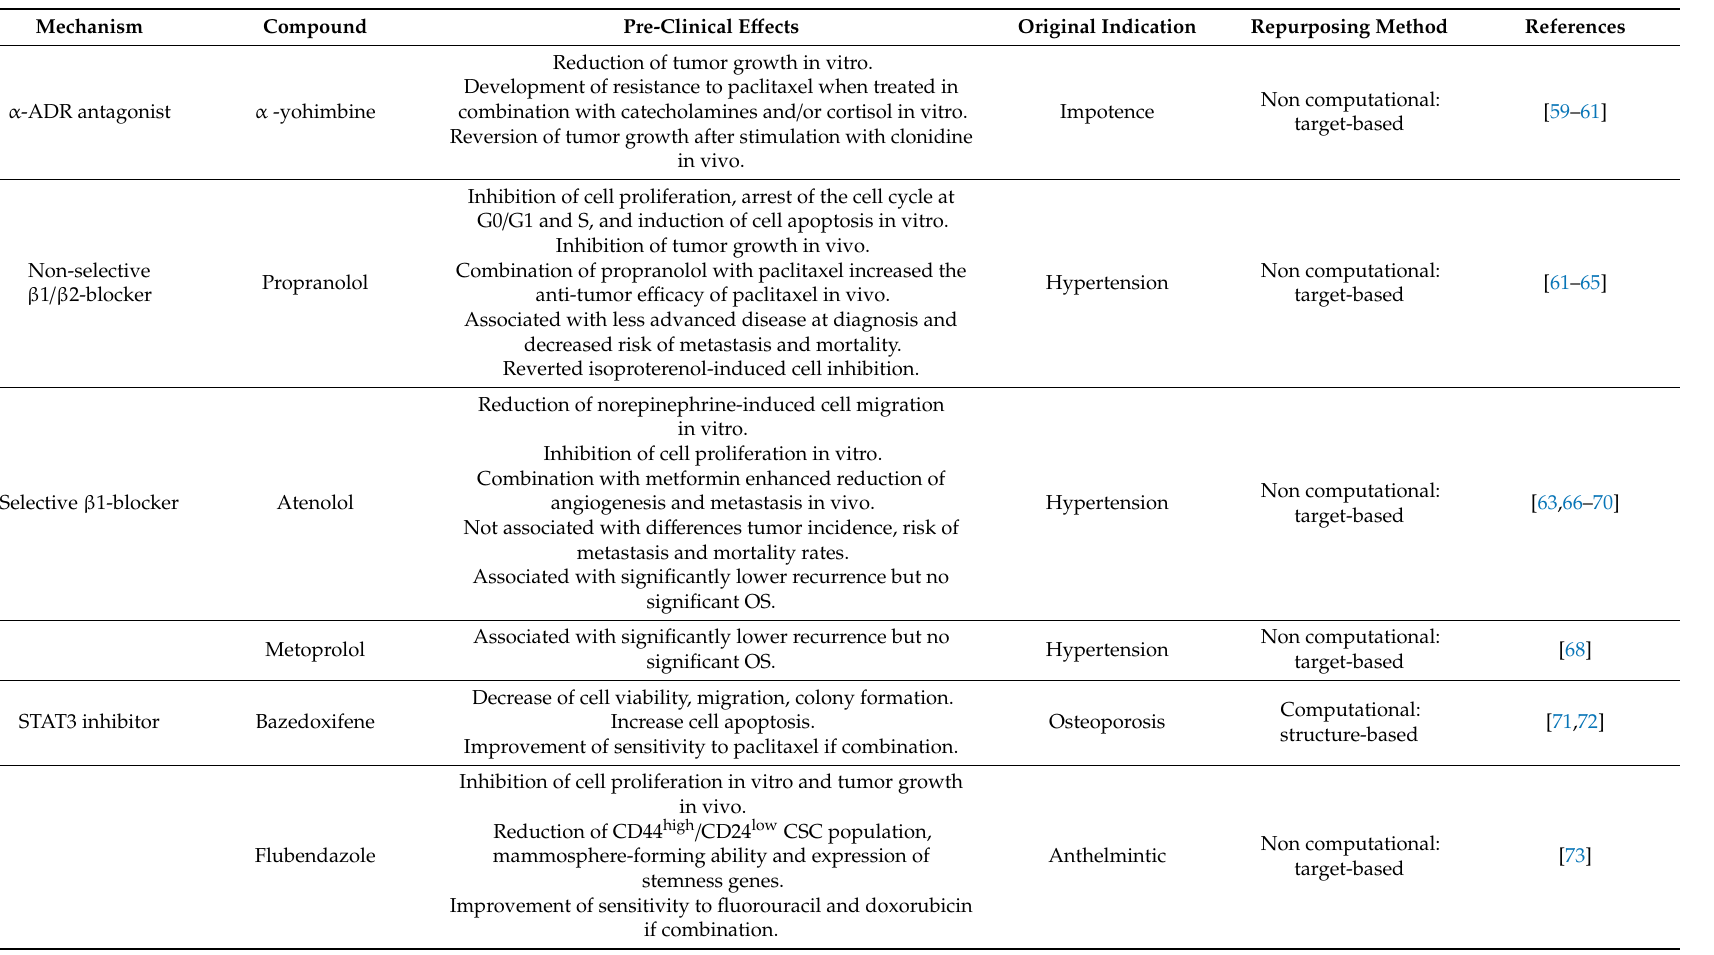
Table 3. Summarized repurposed drugs to treat TNBC that are under investigation in the preclinical